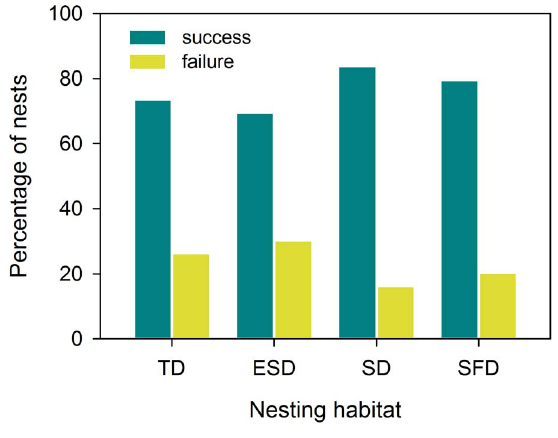
Figure 4. Nest fate in relation to habitat type. From left to right the distance to seashore increases. Abbreviations and sample size: tidal